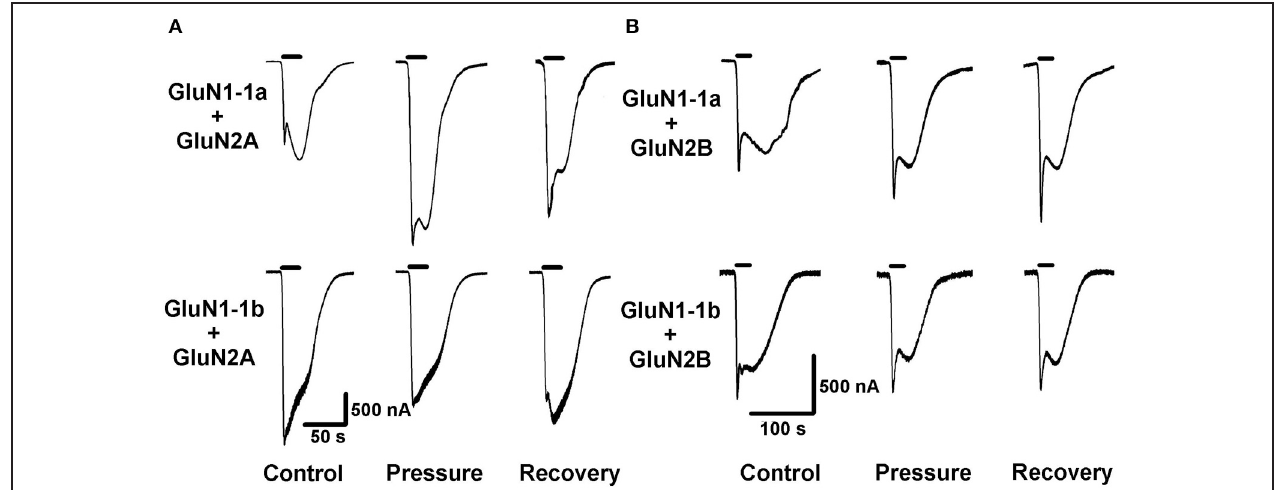
FIGURE 2 | High pressure (HP) effects on GluN2A and GluN2B NMDAR subtypes. (A) HP selectively modulates currents of GluN2A subtypes. Top: HP augments GluN1-1a + GluN2A current. Bottom: HP decreases GluN1-1b + GluN2A current. (B) GluN2B subtypes GluN1-1a + GluN2B and